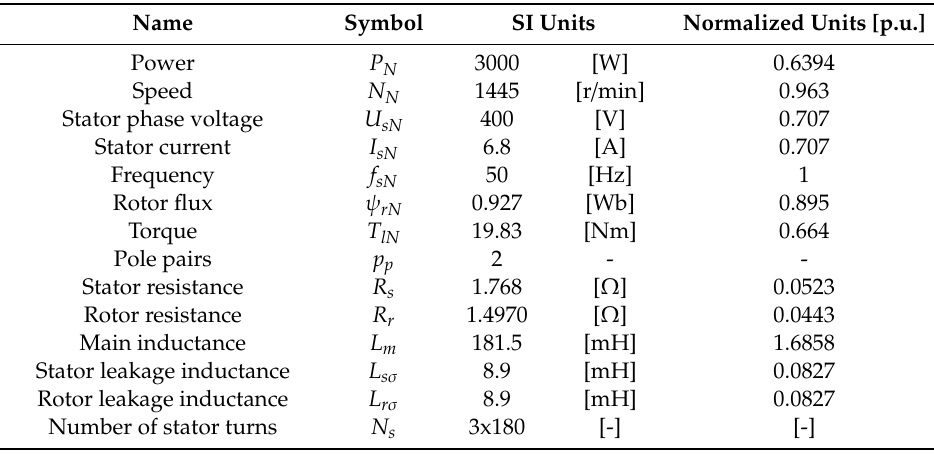
Table A2. Nominal parameters of tested induction